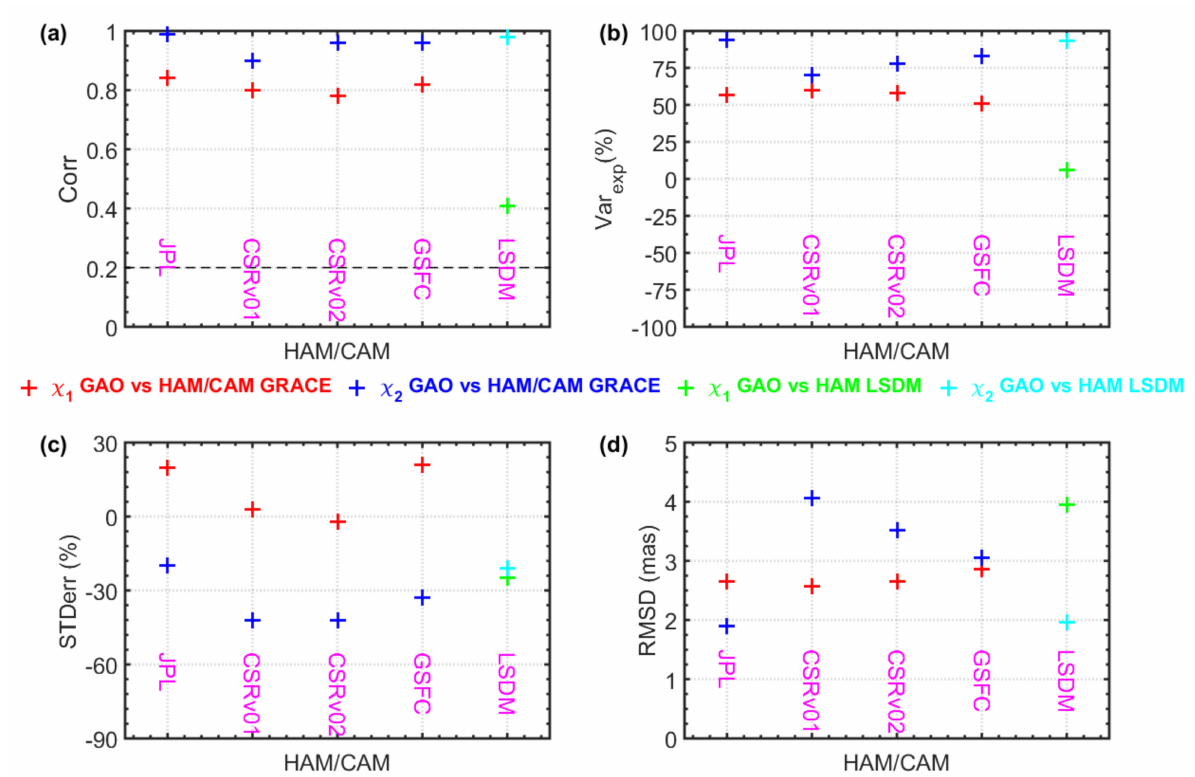
Figure 5. ( a ) Correlation coefficients (Corr) between HAM/CAM and GAO and between HAM and GAO, ( b ) percentage of variance in GAO explained by HAM/CAM and HAM (Var exp ), ( c ) error of STD (STDerr) of HAM/CAM and HAM, and ( d ) root mean square deviation (RMSD) of HAM/CAM and HAM. Seasonal variations are considered. Note that for seasonal variations, the critical value of the correlation coefficient for 68 independent points and a 95% confidence level is 0.20, while the standard error of the difference between the two correlation coefficients is